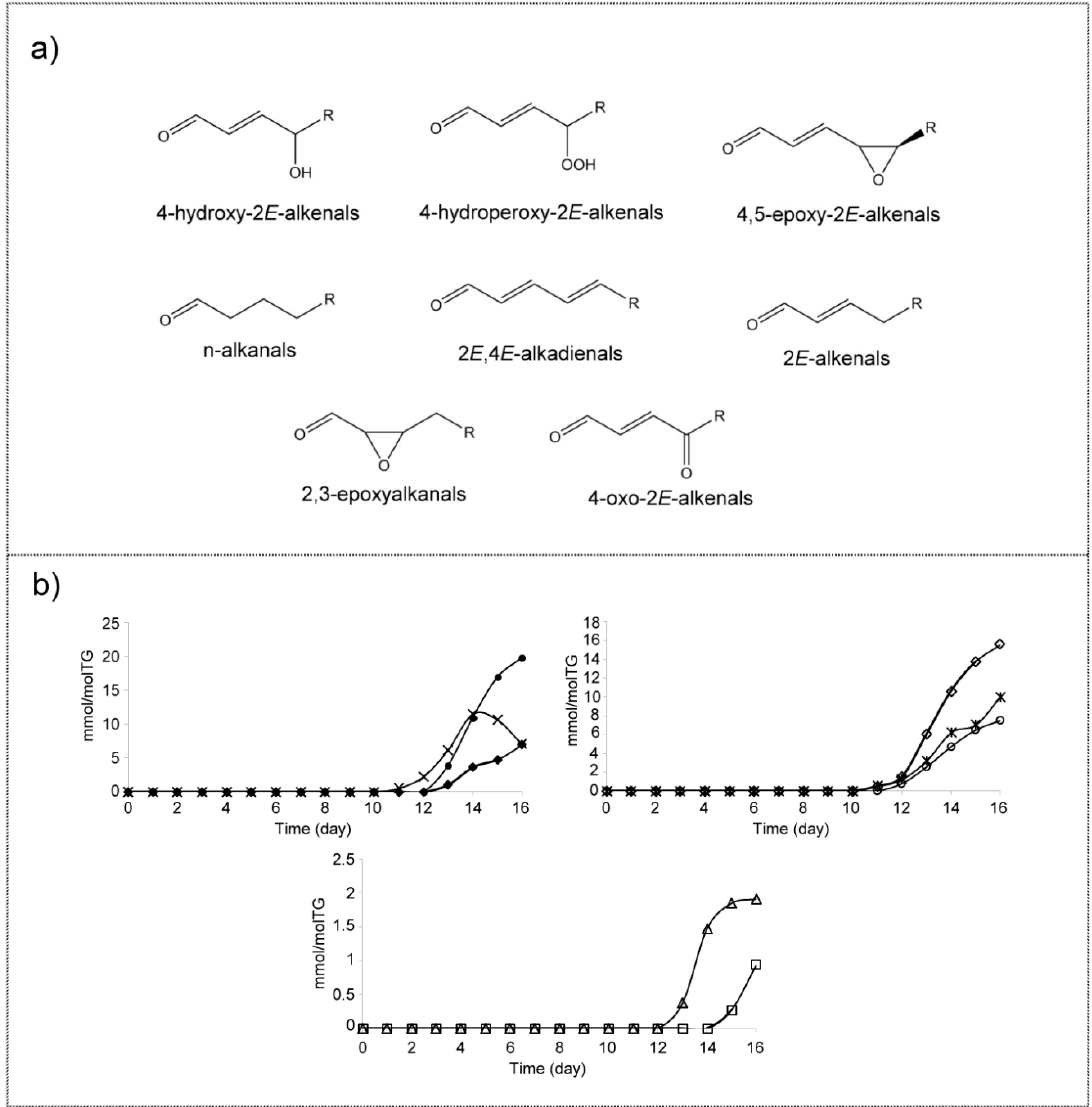
Figure 15. ( a ) Chemical structures of aldehydes detected in this study. ( b ) Evolution of their concentration, expressed as mmol / mol TG versus time given in days of: 4-hydroxy-2 E -alkenals ( • ); 4-hydroxyperoxy-2 E -alkenals (x); 4,5-epoxy-2 E -alkenals ( ♦ ); 2 E -alkenals ( ◊ ); 2 E ,4 E -alkadienals ( ○ ); n-alkanals (*); 4-oxo-2 E -alkenals ( ∆ ); 2,3-epoxyalkanals ( □ ).